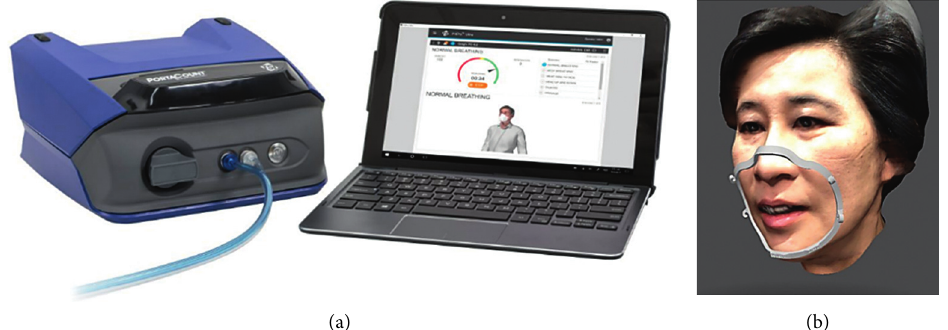
Figure 1: PortaCount and Face Frame. (a) PortaCount respirator fit tester, (b) 3D facial scan, and designed mask fitter from Bellus3D Face App and Bellus3D Dental Table 1: Modified ambient aerosol CNC quantitative fit testing (PortaCount) protocol for filtering facepiece respirators [12]. Exercise Exercises procedure